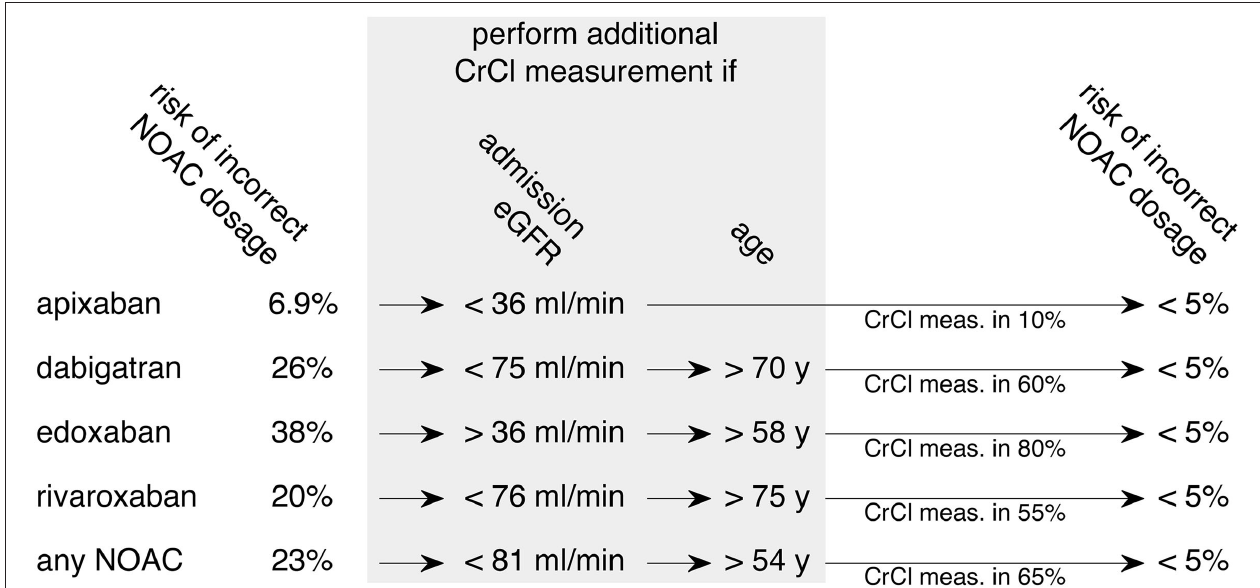
FIGURE 3 | Derived clinical pathway to decrease the risk of incorrect NOAC dosage. Aiming at a reduction of incorrect NOAC dosage below 5%, a clinical decision rule for additional CrCl measurement based on thresholds of the data is displayed. The optimal selection of patients can be adjusted to the individual NOAC that is chosen for therapy (upper four rows). An alternative approach is to consider all NOACs equally when deciding which patients to select for additional CrCl measurement (bottom row). Admission eGFR contains results from eGFR CKD-EPI; meas.,